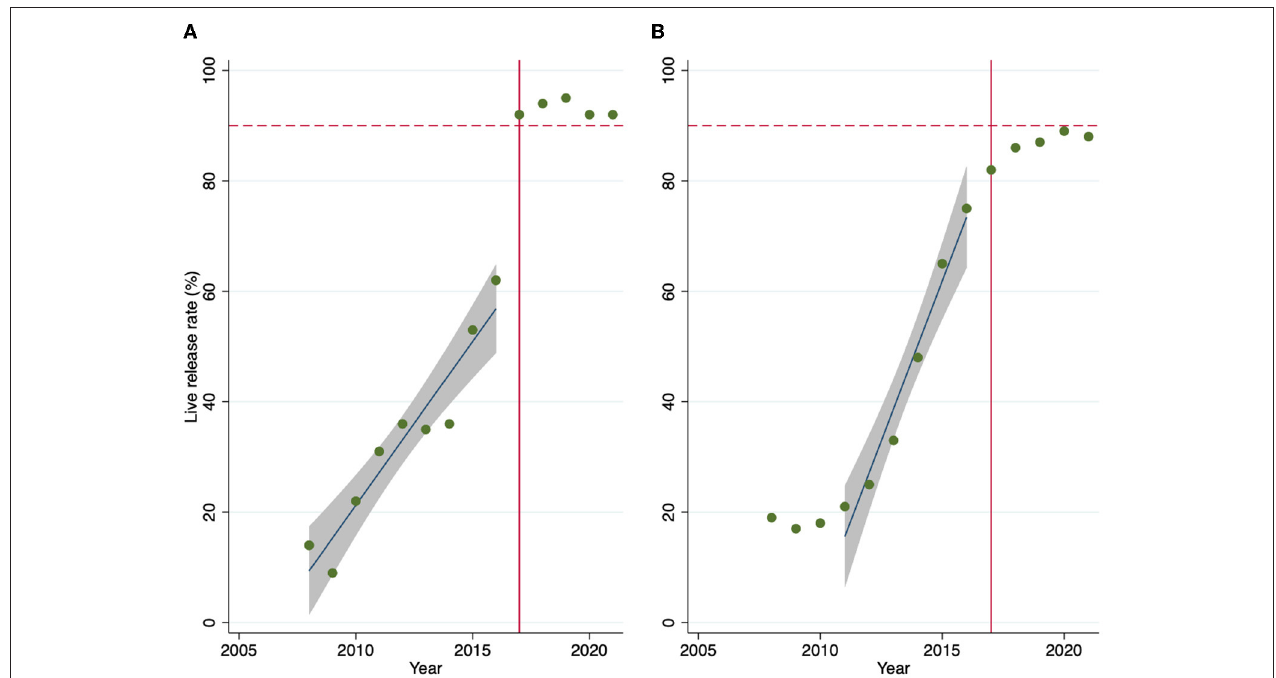
FIGURE 1 | Live release rate for cats (A) and dogs (B) by year overlaid by best fit line and 95% confidence interval for years 2008 to 2016 for cats and 2011 to 2016 (the linear portion of the sigmoid curve) for dogs. Dotted red line at the 90% target live release rate and solid red line at the intervention year.